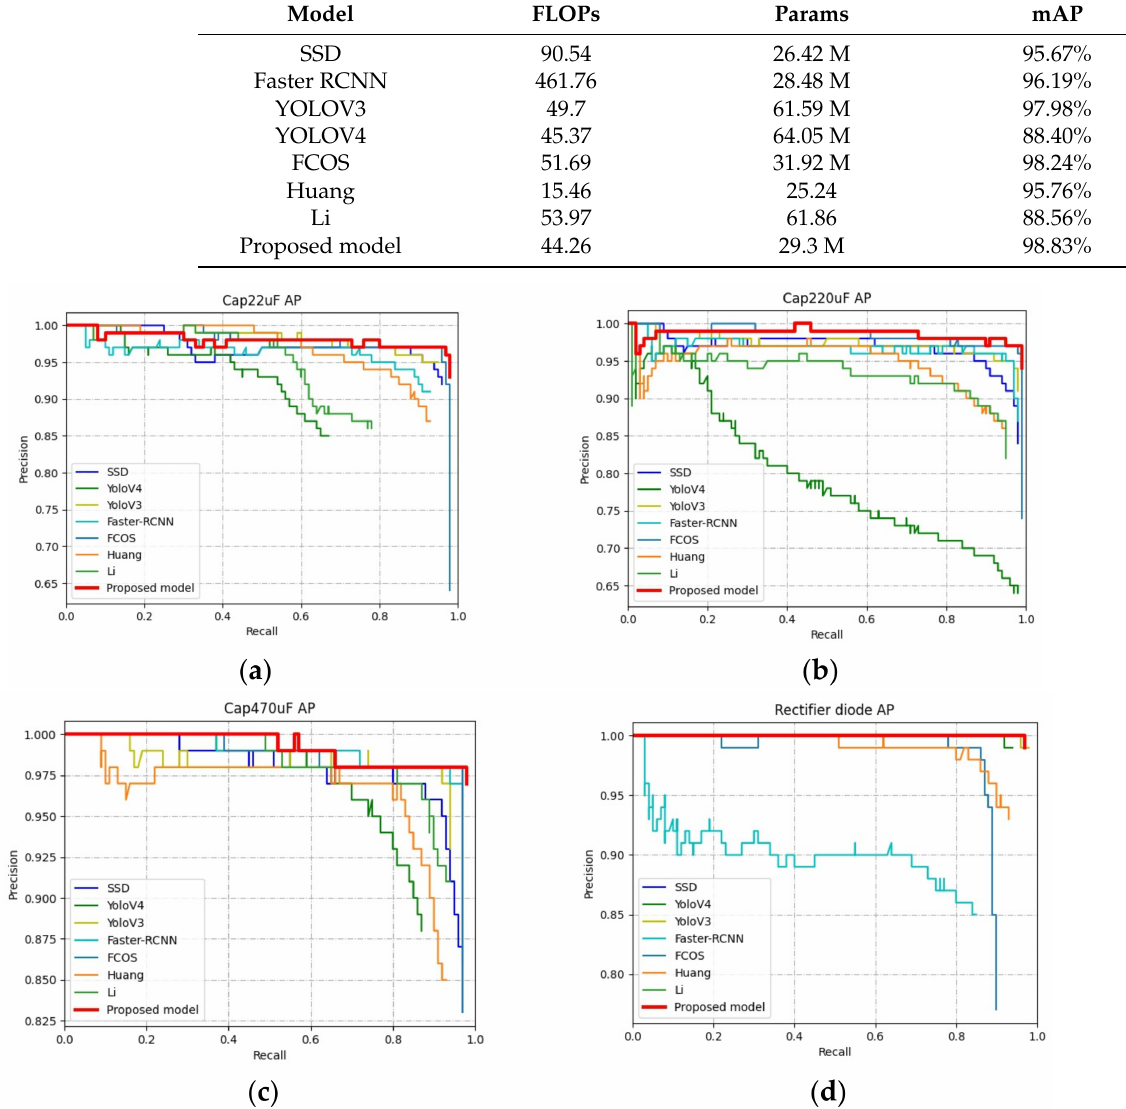
Figure 10. P–R curves of four electronic components from the multi-scene electronic component dataset ( a ) Cap22uF; ( b ) Cap220uF; ( c ) Cap470uF; ( d ) Rectifier